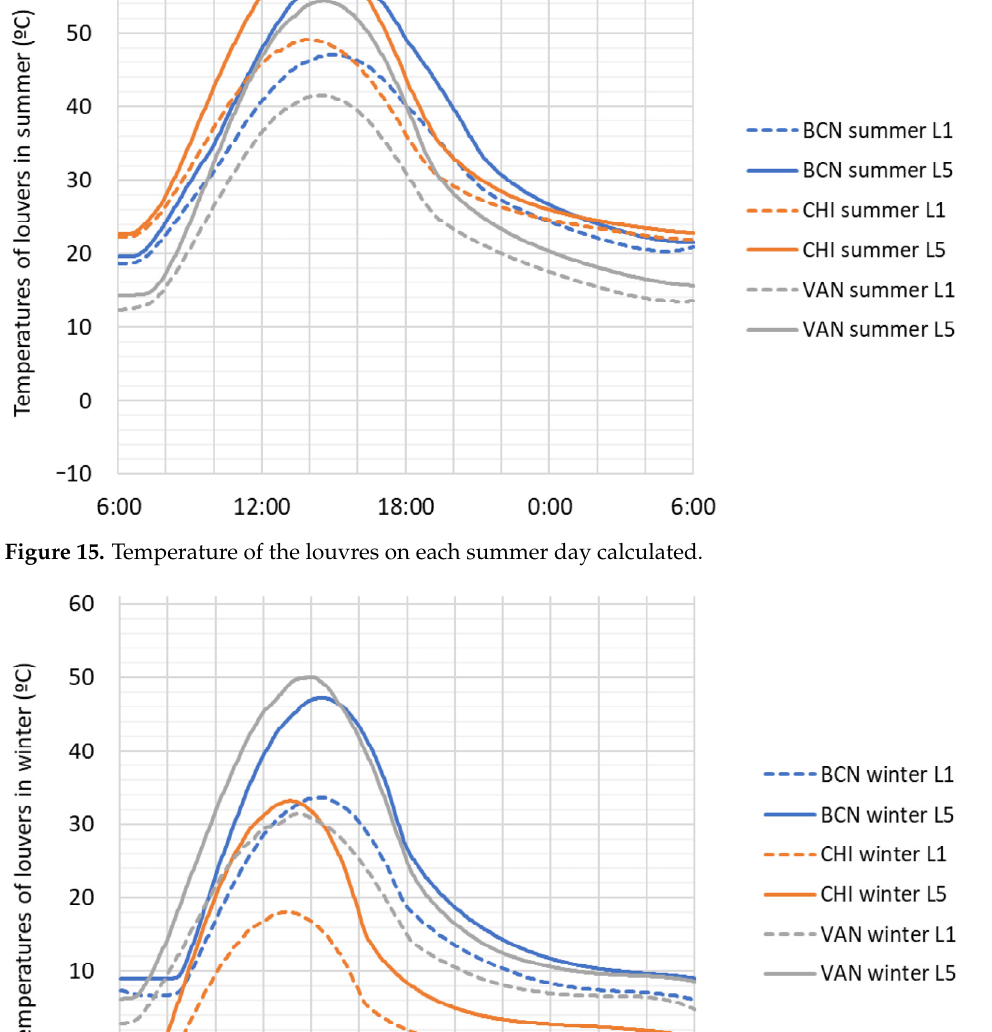
Figure 14. Temperature difference between outlet and inlet air in winter.